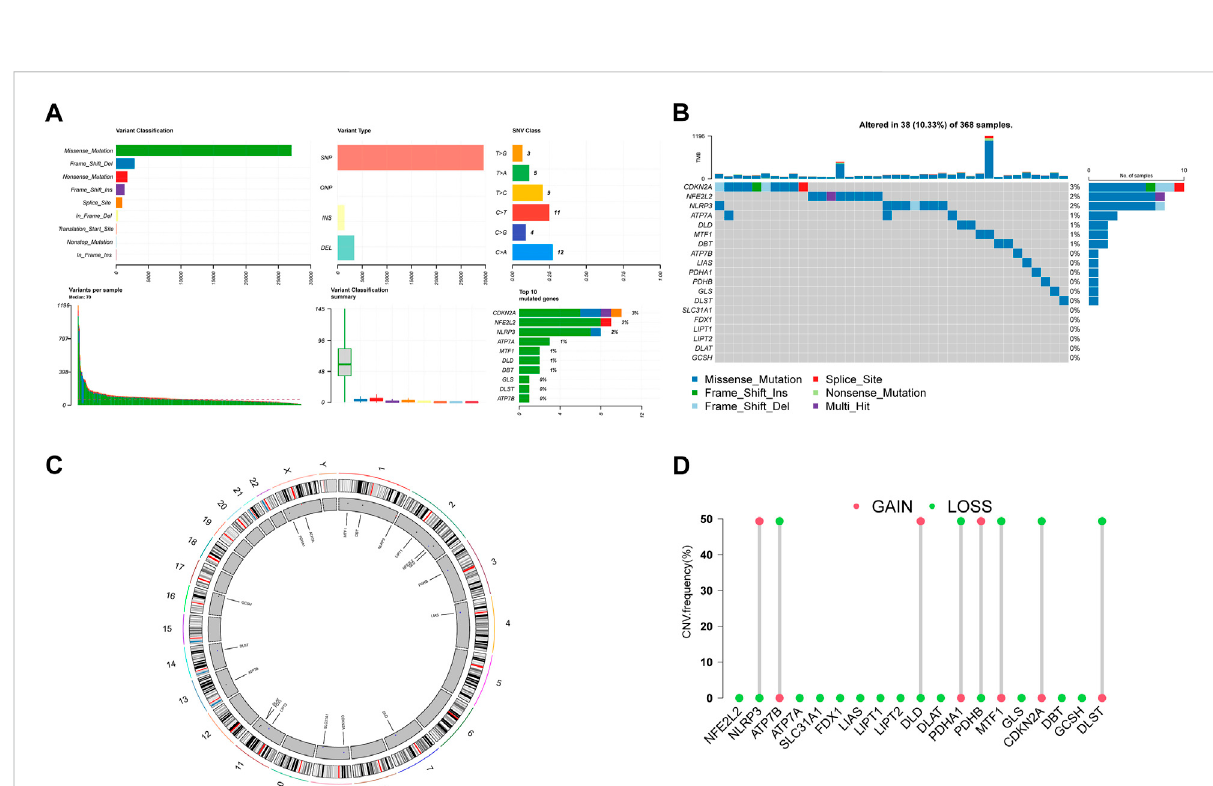
FIGURE 2 LandscapeofgeneticvariationofCRGsinHCC (A) , (B) Themutationoffrequencyandclassi fi cationof19CRGsinHCC. (C) ThelocationofCNV alteration of 19 CRGs on 23 chromosomes in the HCC cohort. (D) The CNV variation frequency of 19 CRGs in the HCC cohort. The height of the column represented the alteration